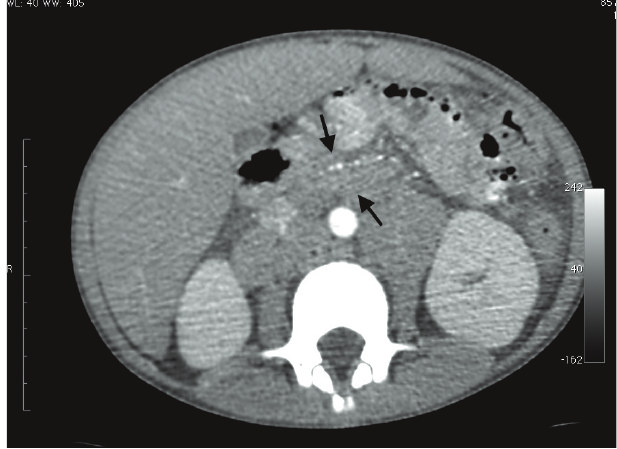
Fig. 1. Axial CT image with intravenous contrast in a 3-year-old diagnosed with non-Hodgkin’s lymphoma shows 2 large mesenteric lymphomatous masses (arrows), which represent the halves of the sandwich bun, enveloping mesenteric fat and enhanced vessels. There is also extensive retroperitoneal lymphadenopathy present.